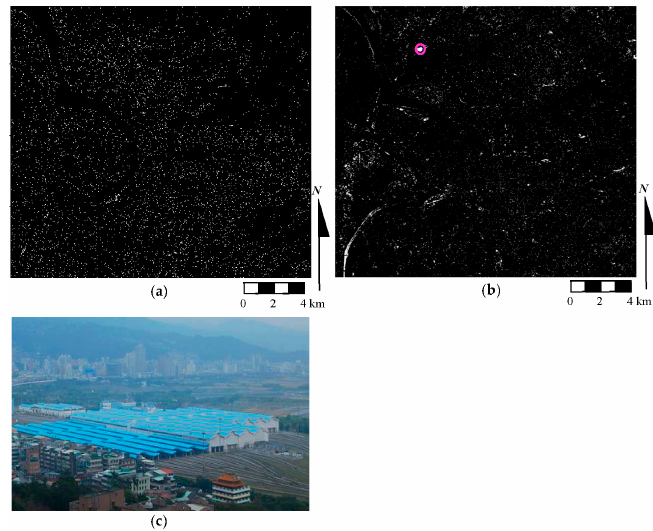
Figure 12. ( a ) Unclassified pixels (white) identified using the equal-likelihood technique with p ∗ max = 0.9; ( b ) unclassified pixels identified using the chi-square threshold technique with p c = 0.05; and ( c ) the Beitou Depot of the Taipei MRT (i.e., the purple-circled area in ( b ))